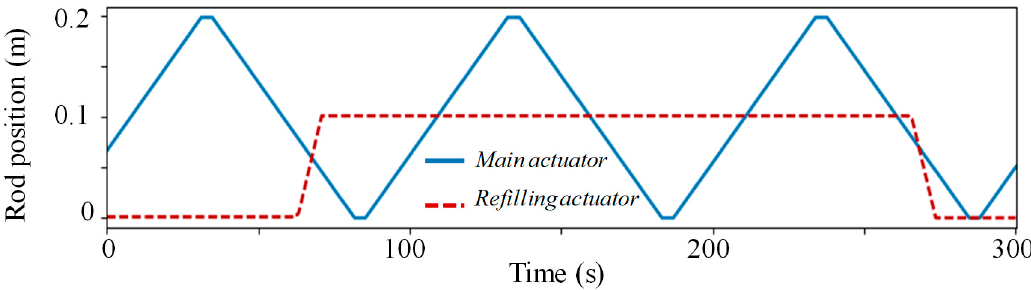
Figure 17. Stroke evolutions of the main and refilling actuators over time, considering a constant thermal power at the evaporator.